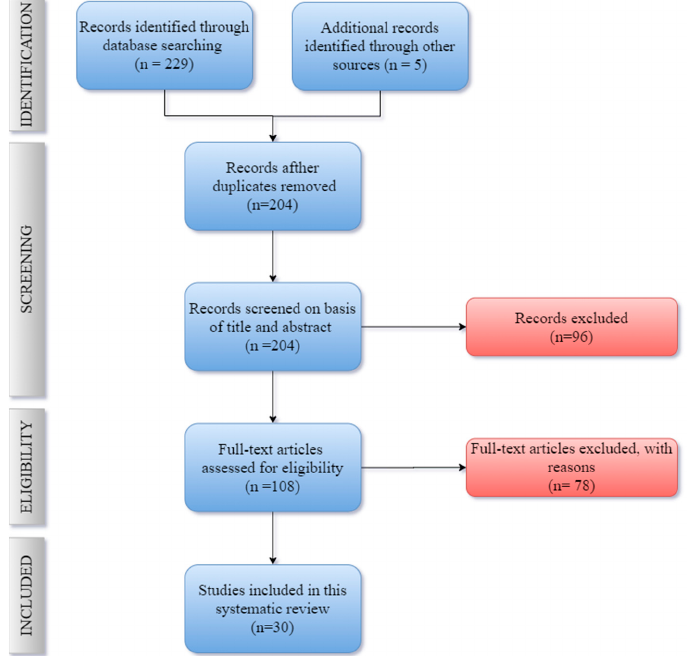
Figure 2. PRISMA flow diagram displaying the procedure of study selection.